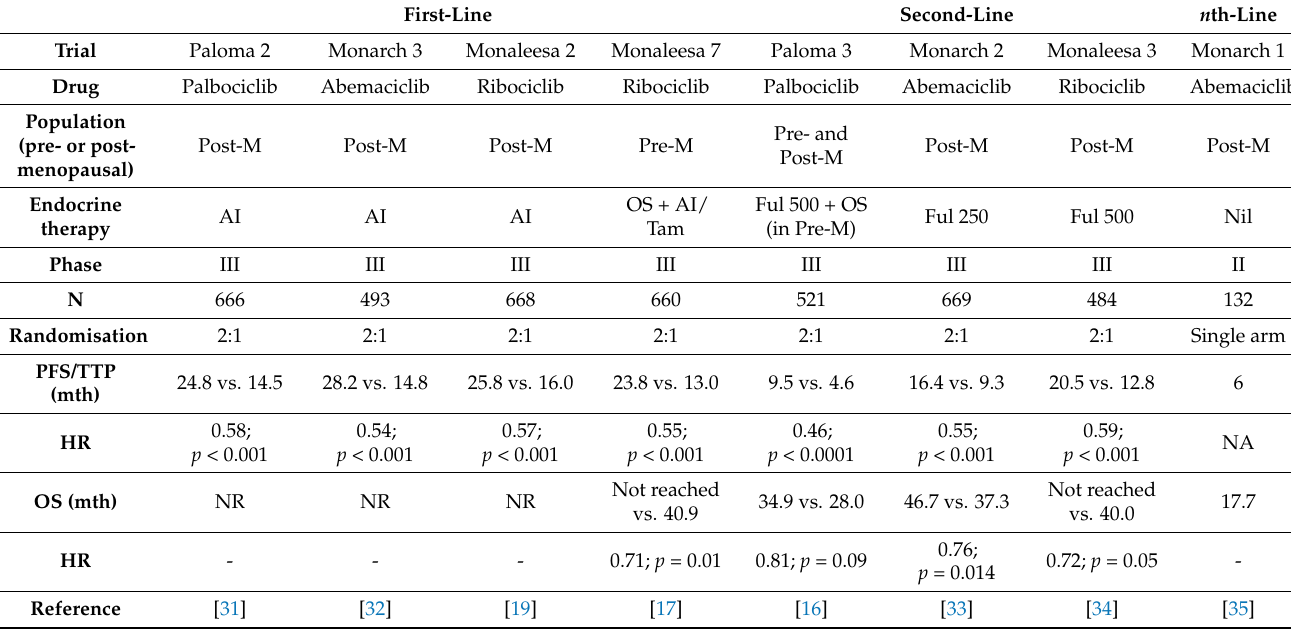
Table 2. Seminal trials of CDK4/6i in advanced breast